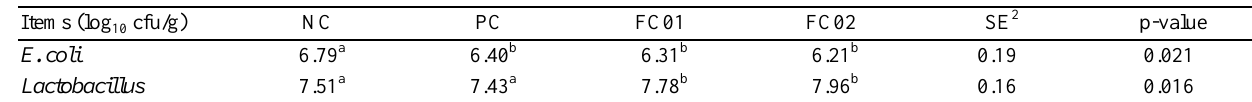
Table 5. Effect of fermented chlorella supplementation on fecal microbial in growing pigs 1 Items (log 10 cfu/g) NC PC FC01 FC02